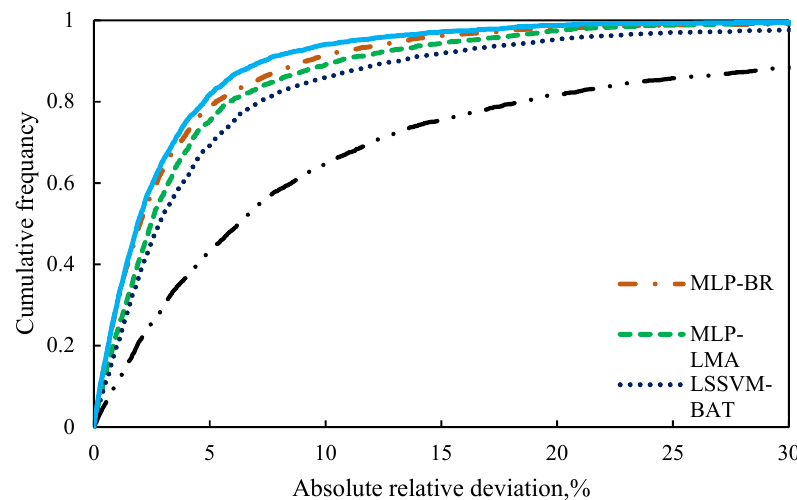
Figure 13. Cumulative frequency of absolute relative deviation in different models based on Model (III).